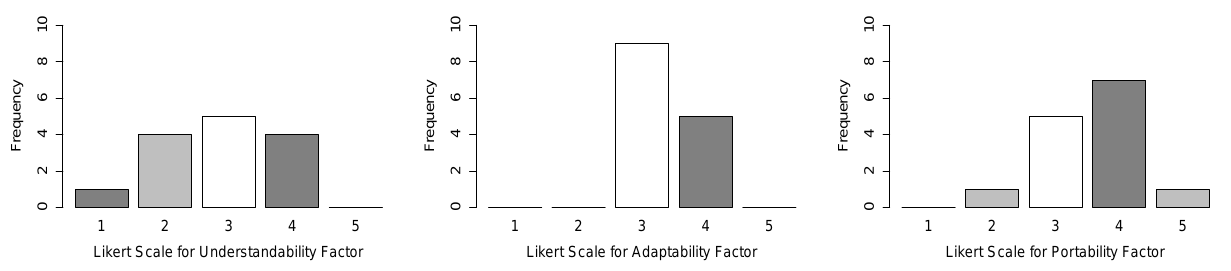
Figure 24. Answers Distribution in Accordance with the Reusability